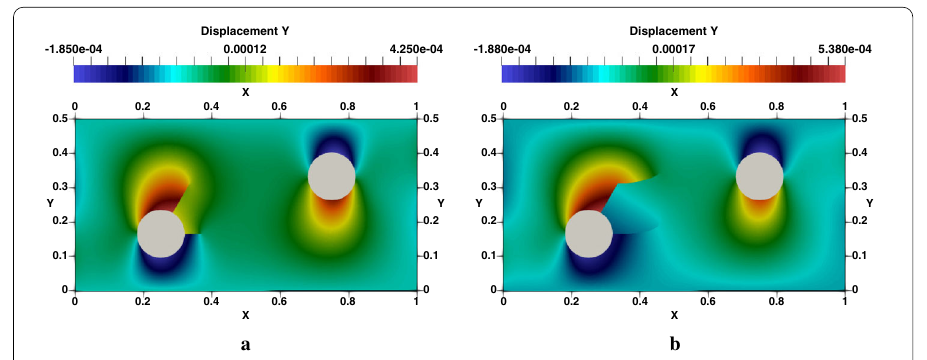
Fig. 27 Crack growth in plate with two circular holes and multiple cracks: e y -displacement; a initial state, b 13 (cid:14) a